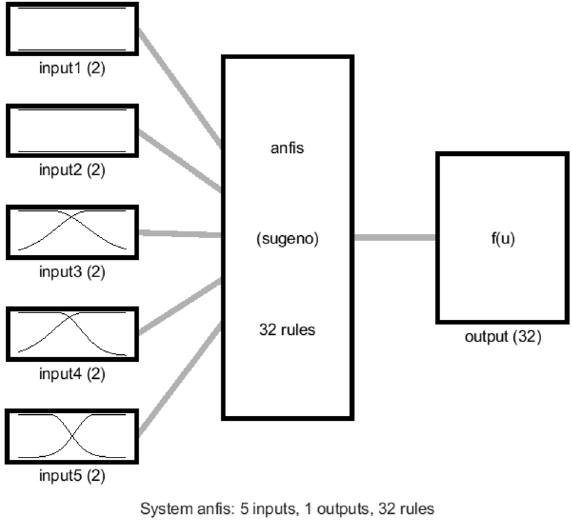
Figure 8. The FIS architecture for the best intelligence. The number of rules =